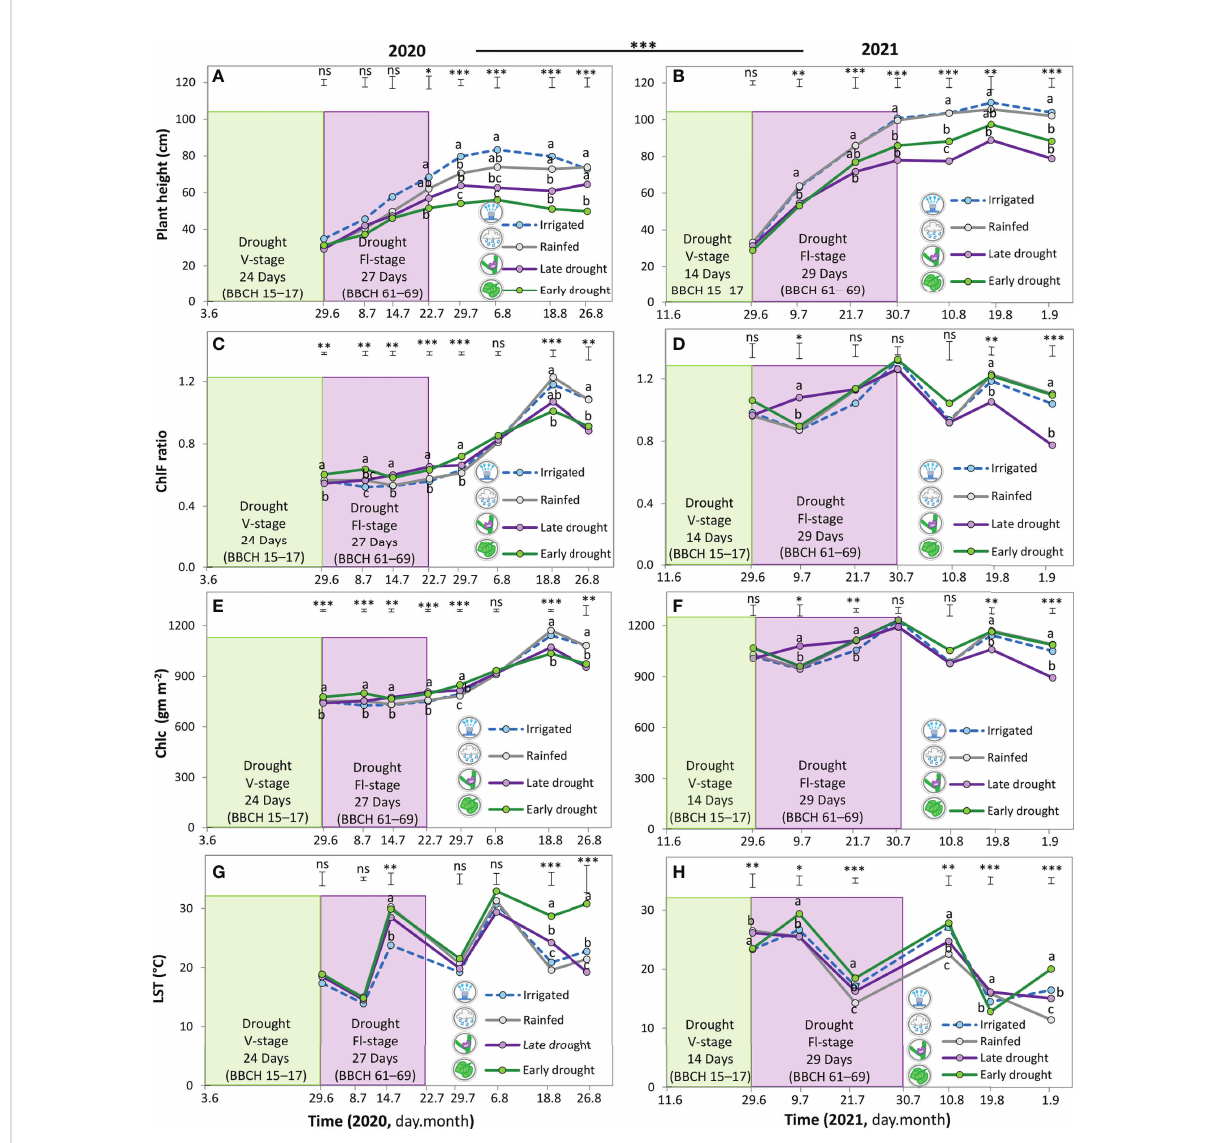
FIGURE 3 Plant height (A, B) , chlorophyll fl uorescence ratio (CFR; C, D ), chlorophyll content (E, F) , and leaf surface temperature (G, H) of soybean under four water treatments, 3 drought scenarios + the control (irrigated) treatments in 2020 (A, C, E, G) and 2021 (B, D, F, H) . The green shaded area indicates the duration of the early drought event at the vegetative stage (V-stage) and the violet shaded area indicates the duration of the late drought event at the fl owering stage (Fl-stage). The vertical bars represent Tukey ’ s HSD test (p < 0.05) at a given point in time (n = 3). Asterisks above the vertical bars indicate signi fi cant differences among the mean of the different treatments when ANOVA result was signi fi cant at P < 0.05; *** P < 0.001, ** P < 0.01,* P < 0.05, ns; not signi fi